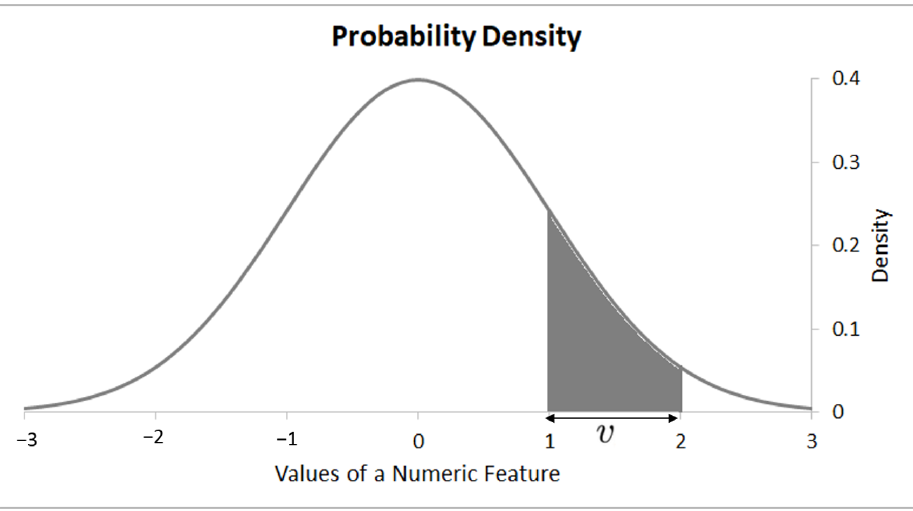
Figure 3. Gaussian distribution of a classification from a continuous